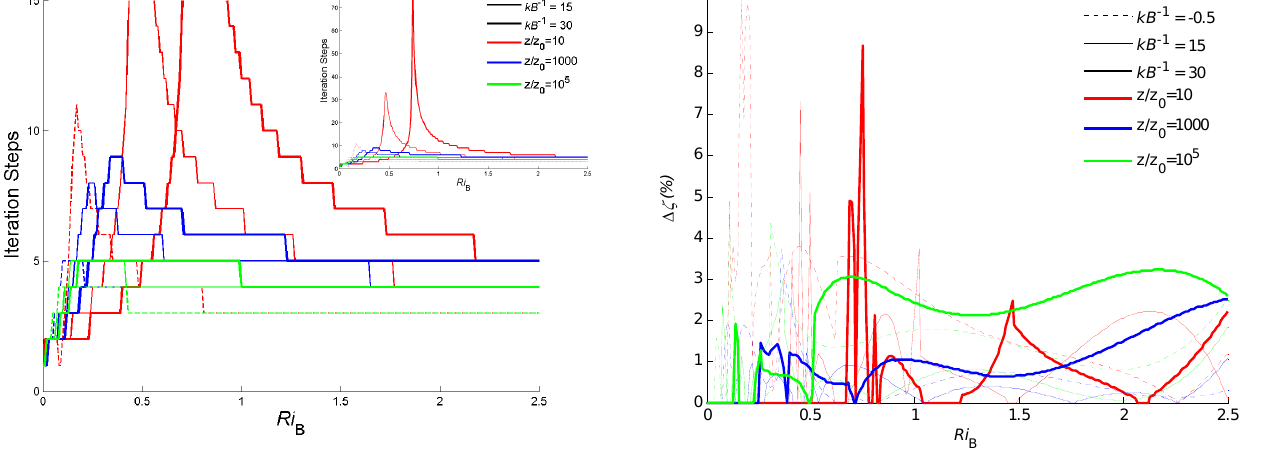
Fig. 7. Relative error with new equations. Figure 7. Relative error with new equations. 2